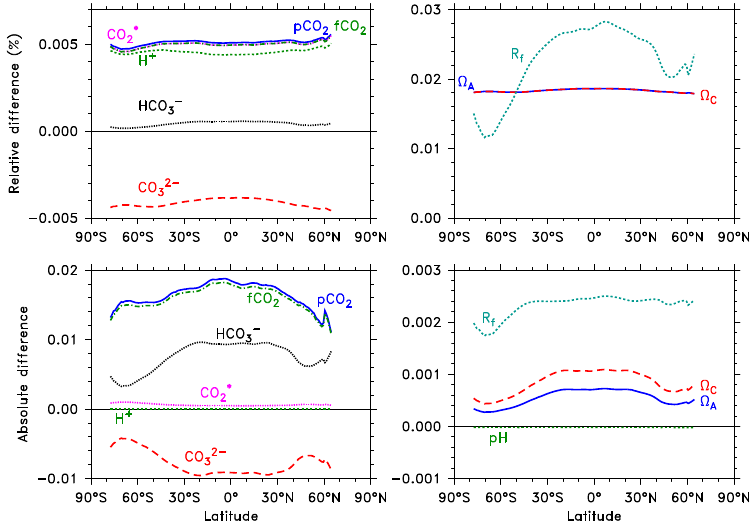
Figure 4. Differences in surface zonal means between mocsy and CO2SYS for computed variables shown as (top) percent relative differences (100 (V mocsy − V co2sys )/V co2sys ) and as (bottom) absolute differences (V mocsy − V co2sys ) . The absolute differences are given in µmolkg − 1 for the three inorganic carbon species, in nmolkg − 1 for H + , and in µatm for f CO 2 and p CO 2 ; other computed variables are unitless.